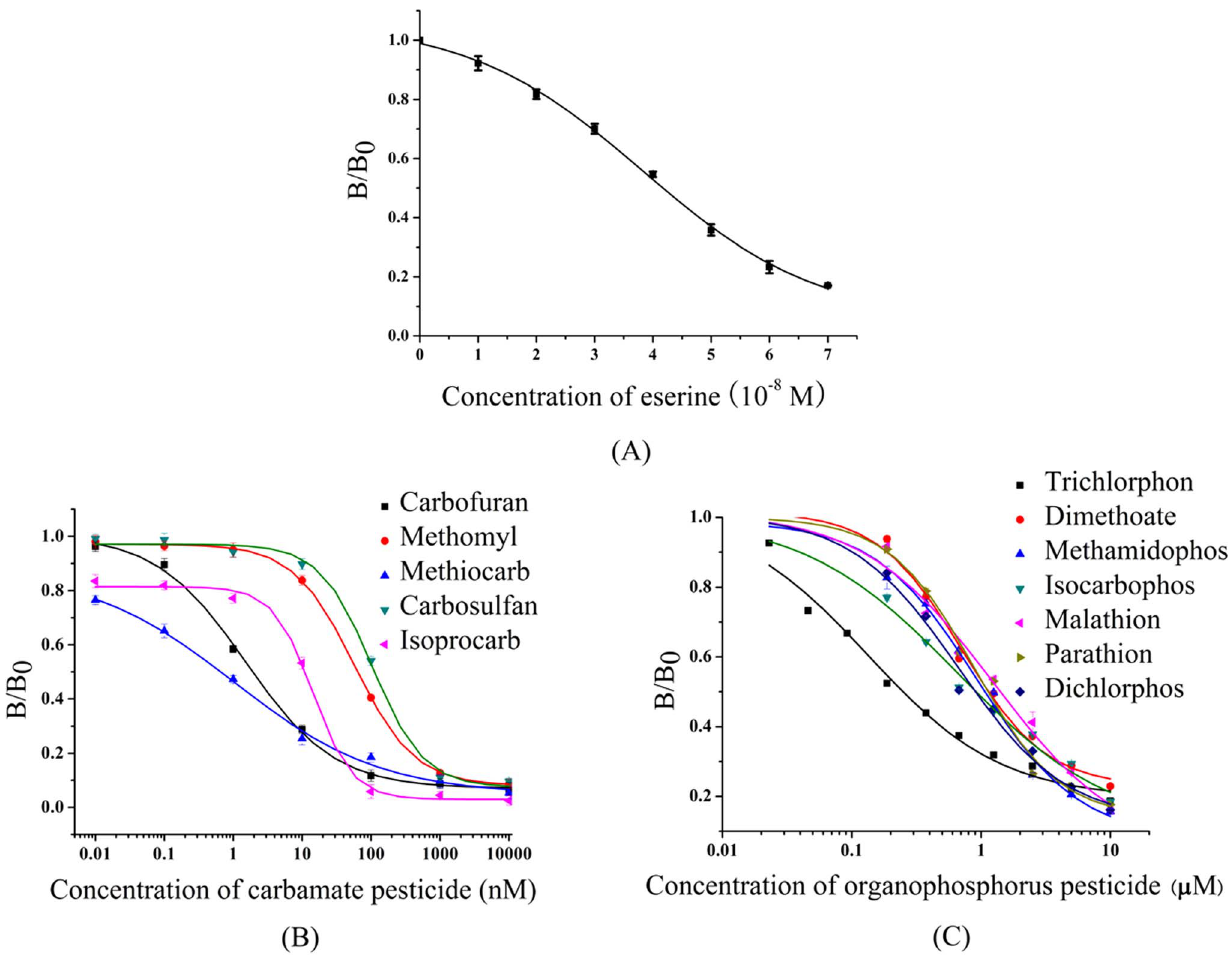
Figure 6. Inhibition curve of displayed Bm AChE. (A), inhibition curve of displayed Bm AChE for eserine; (B), inhibition curve of displayed Bm AChE for CB pesticide (n=3); and (C), inhibition curve of displayed Bm AChE for OP pesticides (n=3). B, the average absorbance at the indicated concentrations; B 0 , the average absorbance at zero concentration. The data were fitted with a four-parameter-logistic equation to calculate the IC 50 using OriginPro 7.5 software. The data points are mean values and the errors observed from triplicate